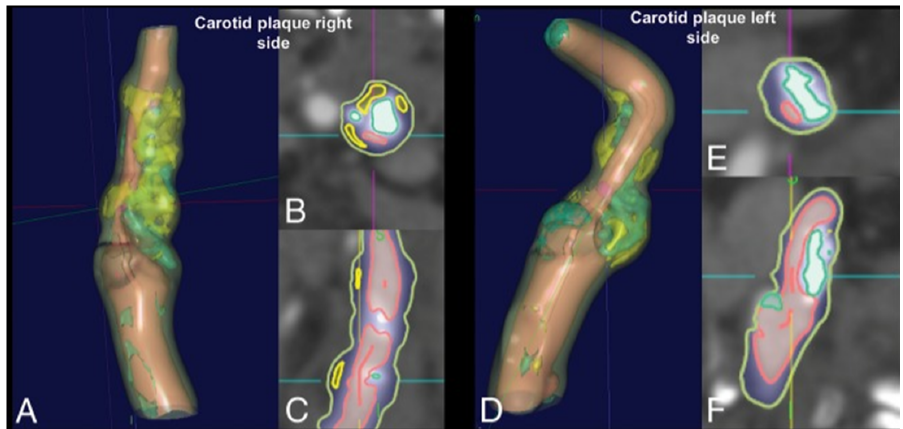
Figure 17. Carotid plaque with bilateral intraparenchymal hemorrhage [218]. (Carotid plaque right side, ( A ): 3D view, ( B ): top view, ( C ): side view, Carotid plaque left side ( D ): 3D view, ( E ): top view, ( F ): side view.)